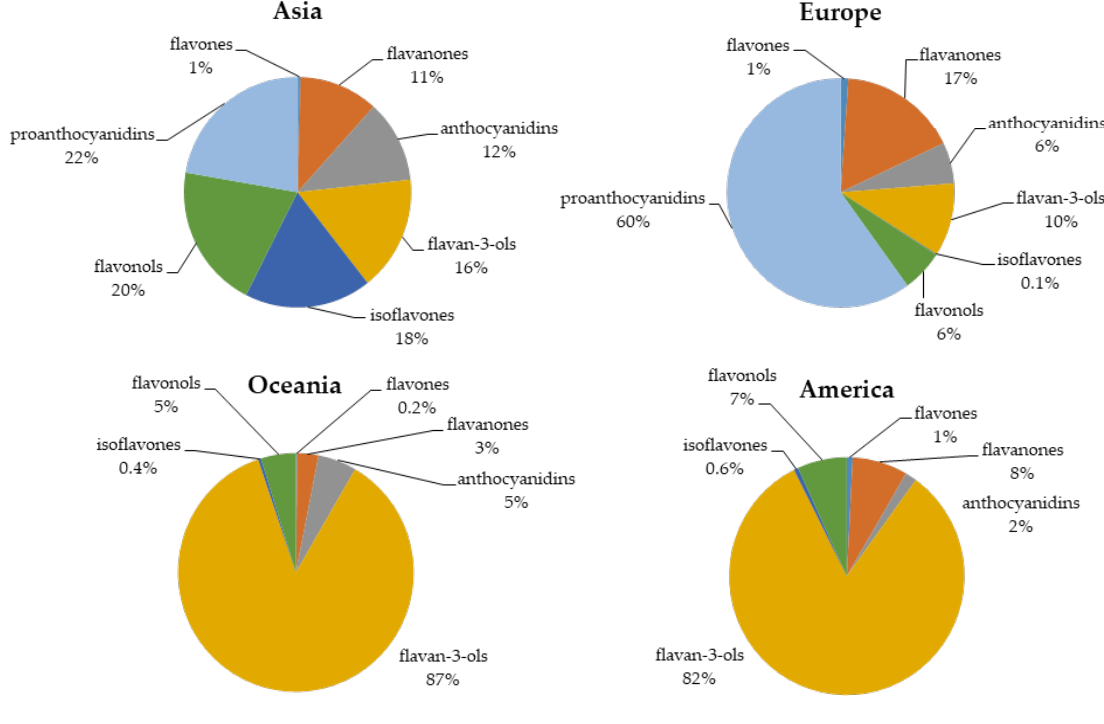
Figure 4. Worldwide intake of flavonoid subclasses.